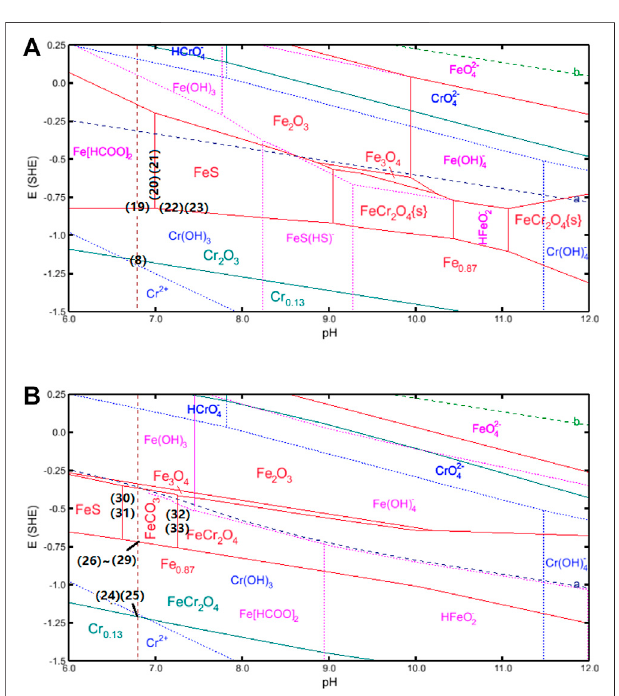
FIGURE 11 | Pourbaix diagram for S13Cr SS under the formate